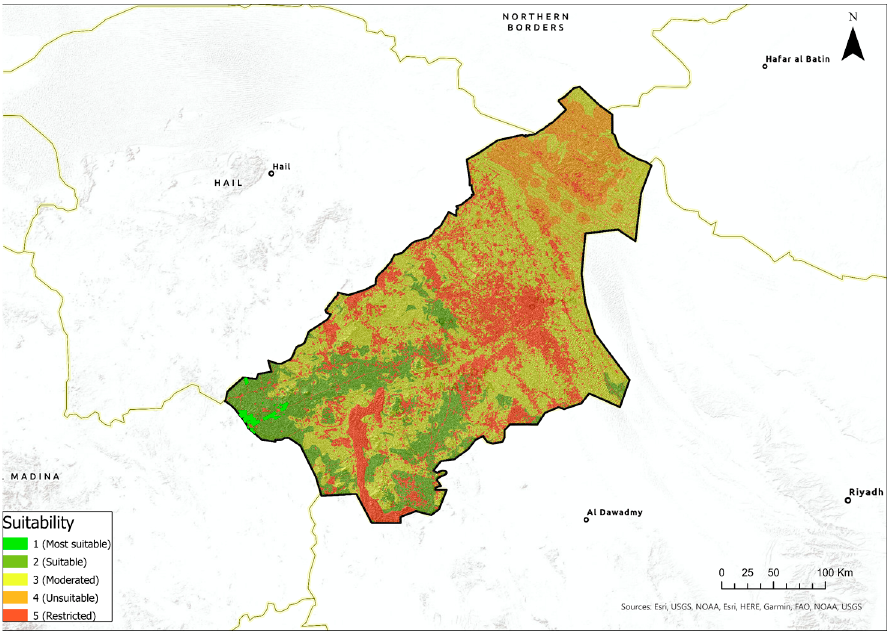
Figure 9. The optimal site map for the Al-Qassim region using multicriteria decision making and AHP evaluation.